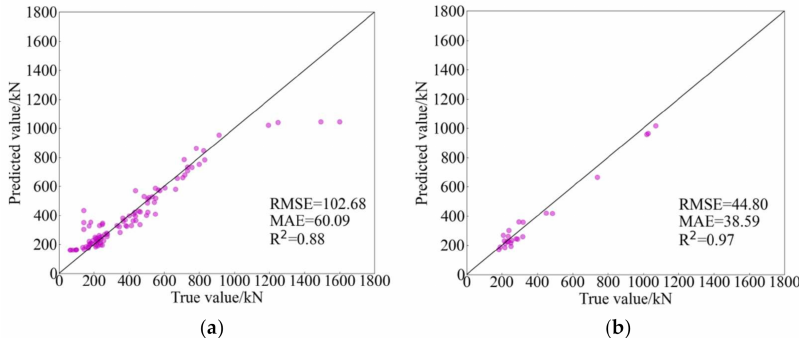
Figure 4. The predictions of ANN for data set. ( a ) Training set; ( b ) Test set.